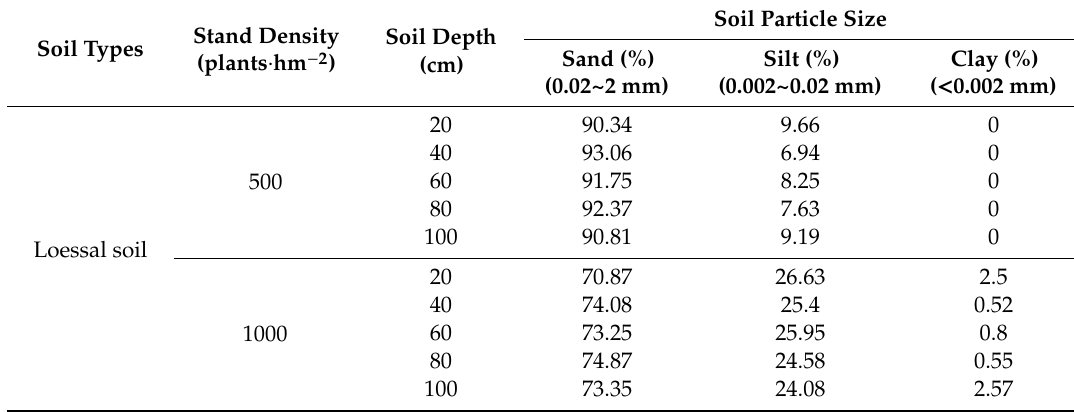
Figure 4. Soil moisture content in R. pseudoacacia forestland of different stand densities. Table 2. Soil particle size analysis in R. pseudoacacia forestland of different stand densities.